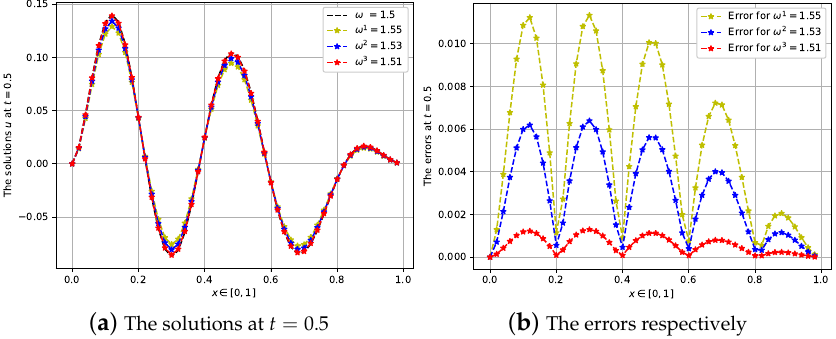
Figure 7. The solution u for ω = 1.5, ω i ∈ { 1.55,1.53,1.51 } at t = 0.5 and the respective